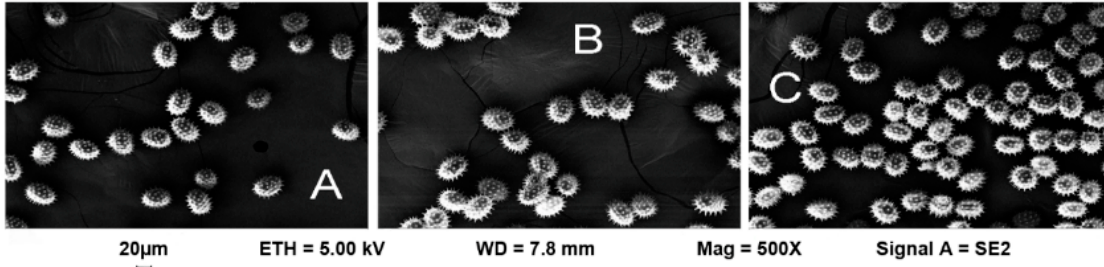
Figure 1. The morphology of pollen grains showed by scanning electron microscopy (500 × magnification) in conventional ( A ), wild ( B ) and IMI-tolerant ( C ) sunflower populations.